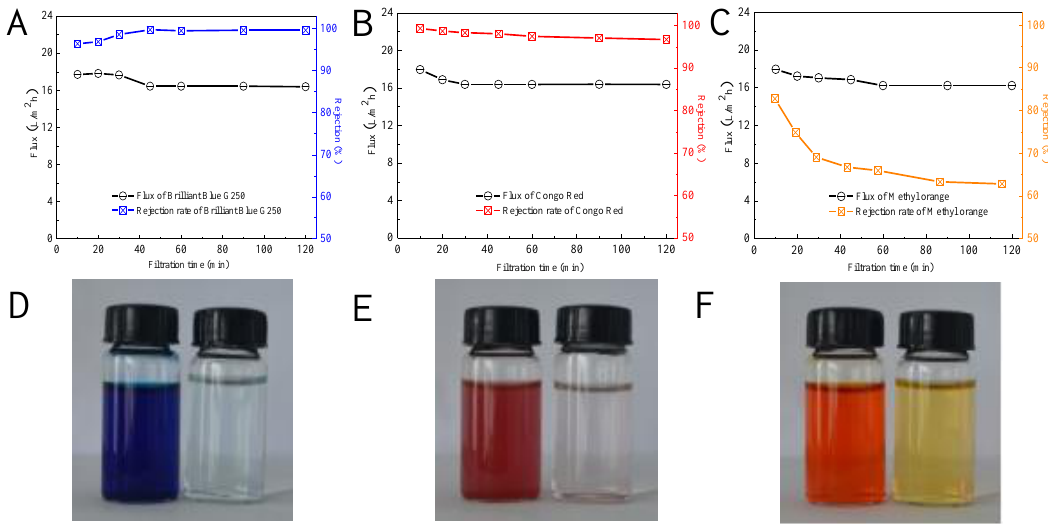
Figure 7. The flux and rejection of dyes solution by the kaolin/CaAlg membrane. The digital photos of feed solution ( right ) and permeate solution ( left ). ( A ) Brilliant Blue G250 ( M W = 854.02 Da), ( B ) Congo Red ( M W = 696.68 Da), ( C ) Methylene orange ( M W = 332.40 Da), ( D ) Right: Brilliant Blue G250; Left: permeate solution, ( E ) Right: Congo Red; Left: permeate solution, ( F ) Right: Methylene orange; Left: permeate solution.